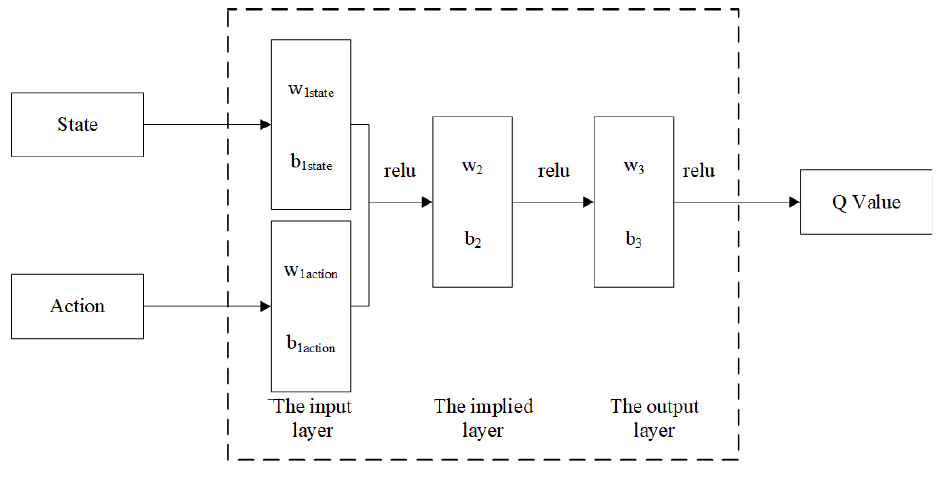
Figure 3. Critic network